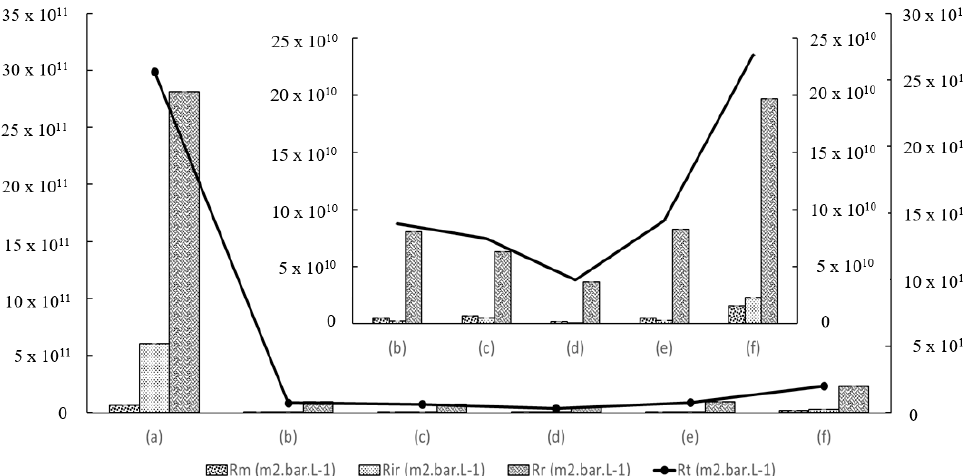
Figure 8. Profile of reversible, irreversible, and total resistances for (a) PES 0, (b) PES 1, (c) PES 2, (d) PES 3, (e) PES 4, and (f) PES 5. Inset represents the magnified graph of (b) PES 1, (c) PES 2, (d) PES 3, (e) PES 4, and (f) PES 5.